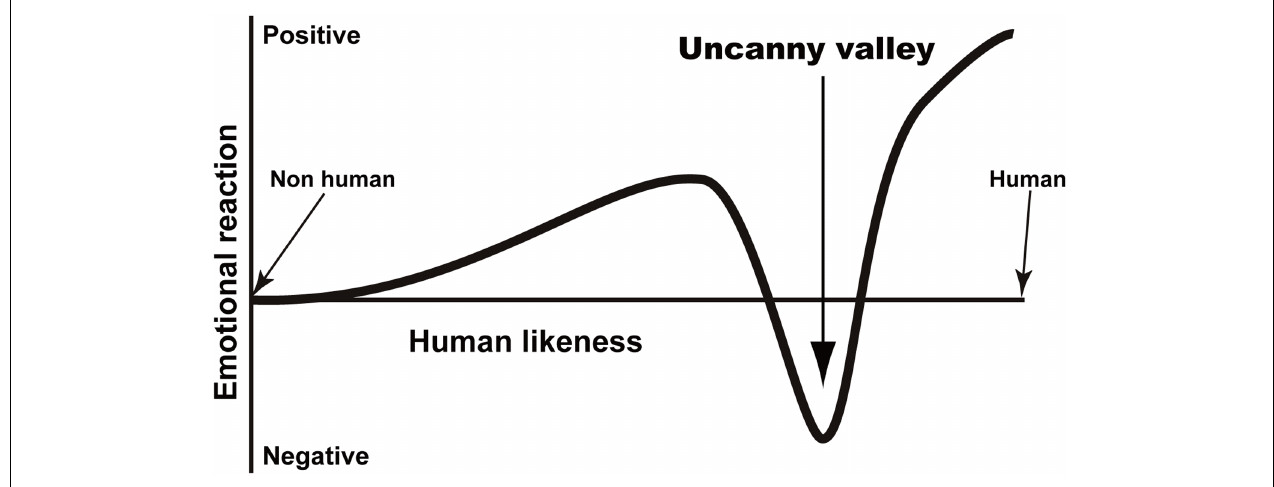
FIGURE 1 | A schematic representation of the uncanny